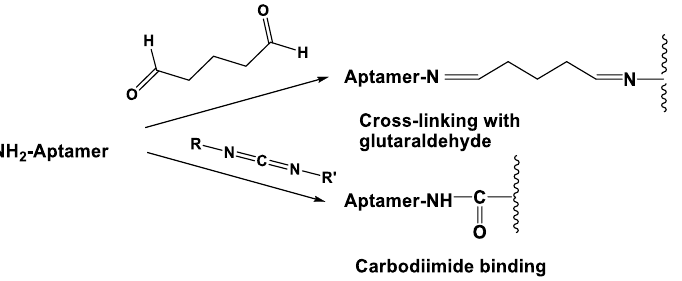
Figure 5. Covalent attachment of aminated aptamer to an insoluble carrier or electrode .